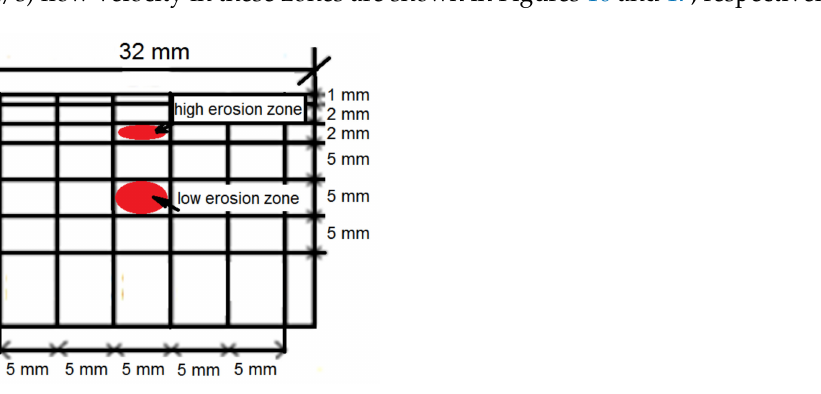
Figure 15. The observation areas of damage developed on the surface of S235JR steel during cavitation erosion